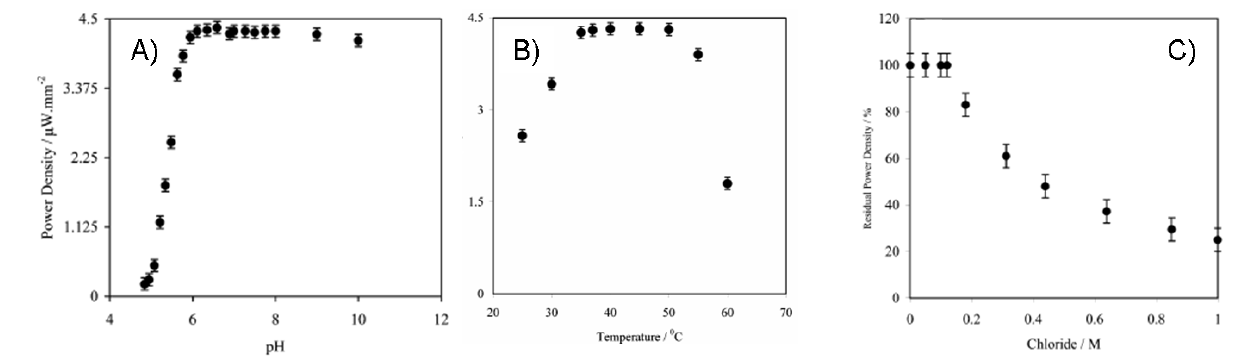
Figure 9. Dependence of the power density of Os polymer based biofuel cell on (A) pH, (B) temperature and (C) chloride concentration under constant polarization at 0.52 V in presence of 15 mM glucose. Reprinted with permission from [83]. Copyright 2003 American Chemical